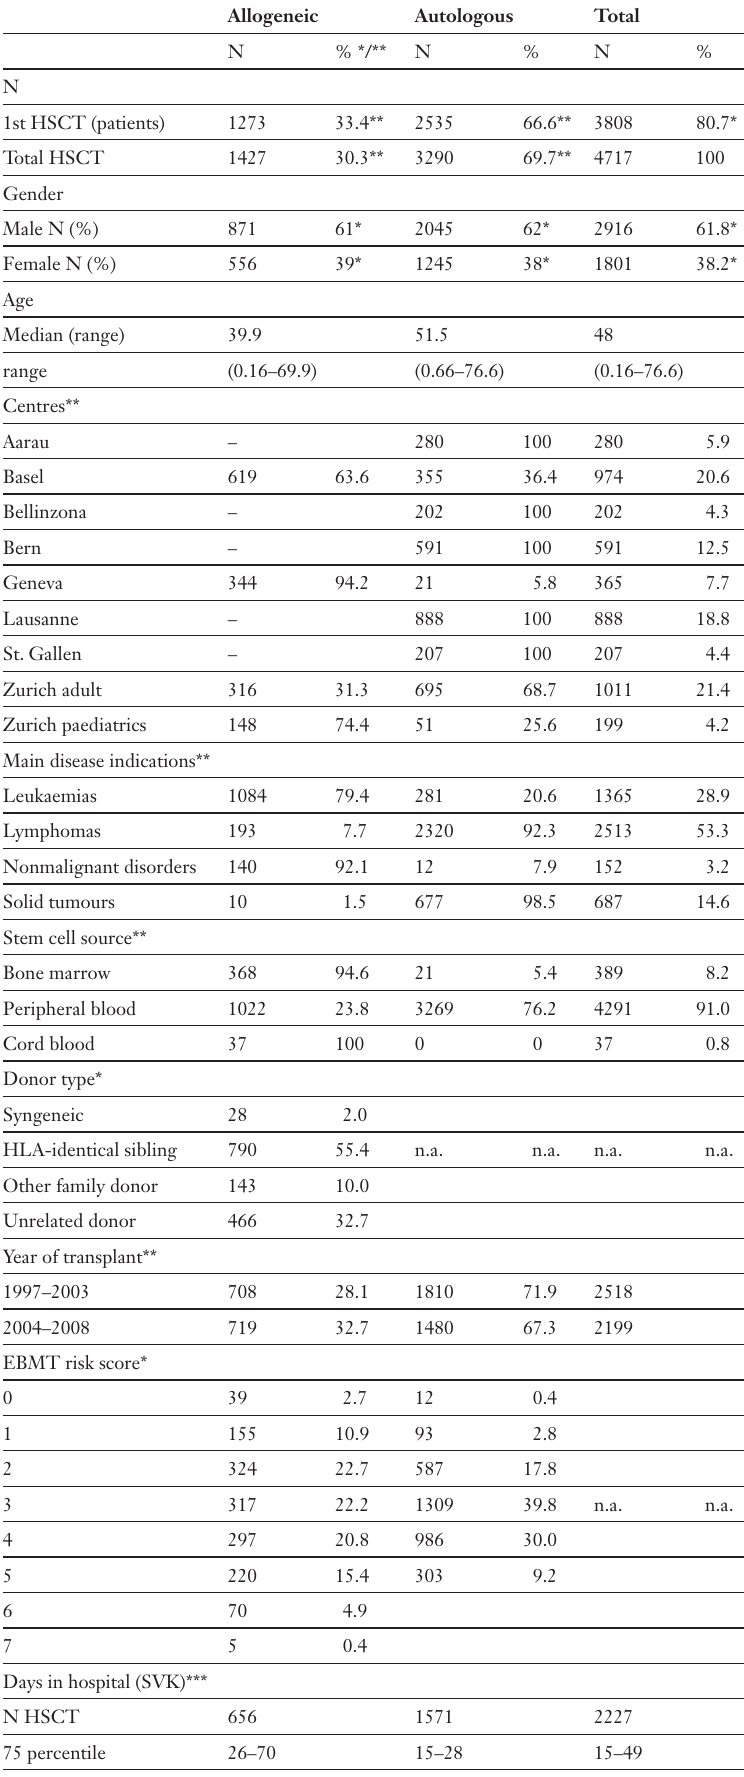
Key characteristics of 4717 HSCT performed in Switzerland from 1997 to